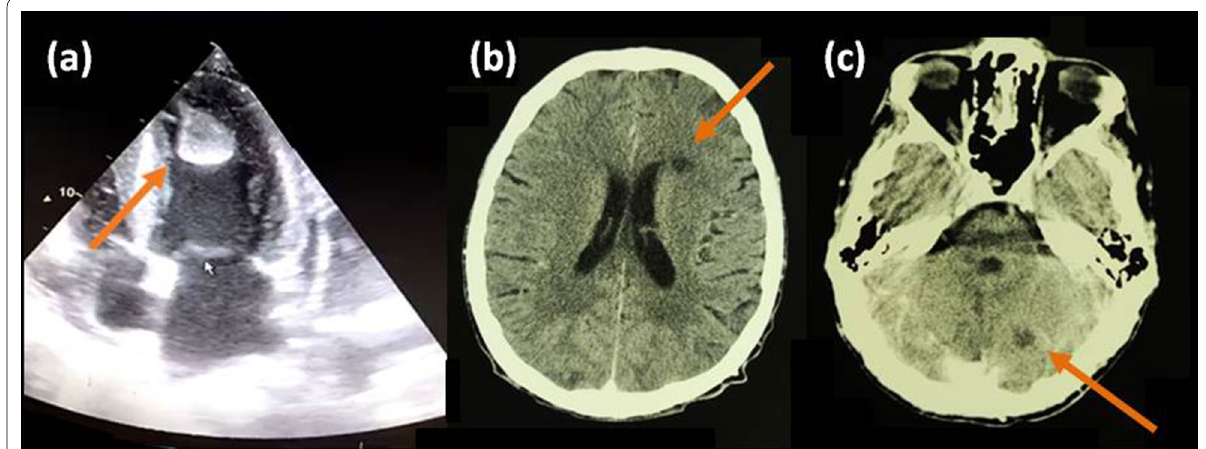
Fig. 1 Pre-IVT TTE exhibiting LV thrombus (3.5 2.5 cm) with a narrow stalk ( a ) and CT scan demonstrating an ovoid hypodense lesion located in × the vicinity of the left frontal horn (paraventricular white matter) ( b ) and a second similar hypodense lesion located in the left cerebellar hemisphere ( c ). Both CT lesions are imaging-wise compatible with lesions of a late subacute